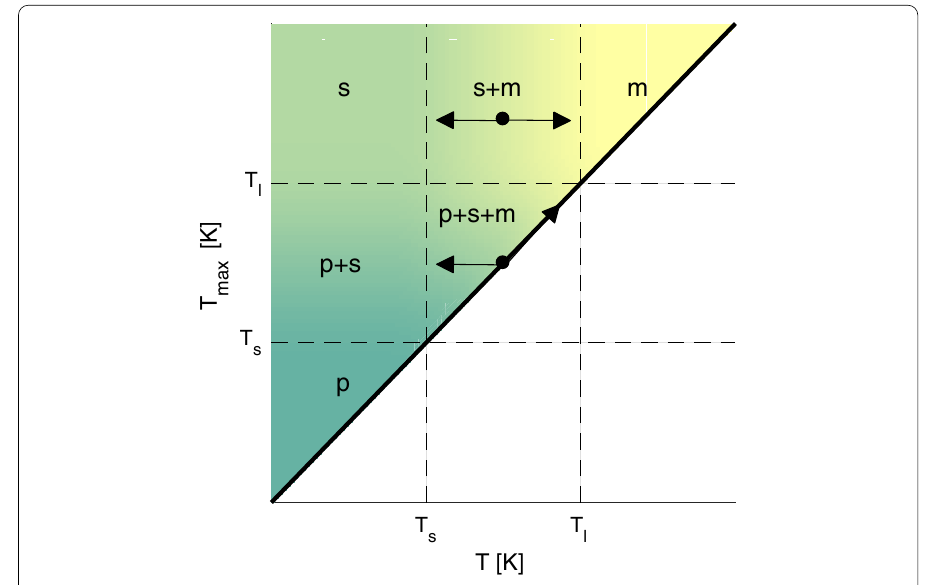
Fig. 2 Temperature history diagram illustrating the two-dimensional nature of material parameter interpolation between powder (p), melt (m) and solid (s). Arrows indicate possible movement within the diagram